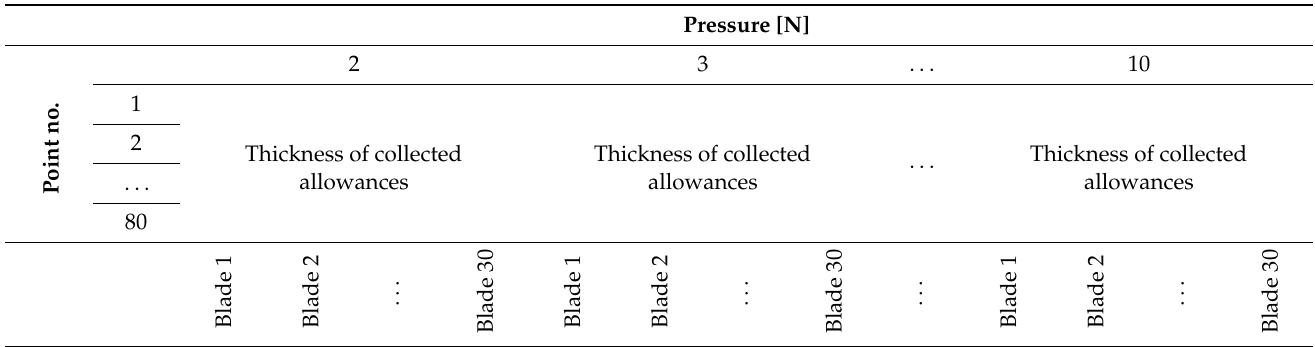
Table 1. The structure of learning neural